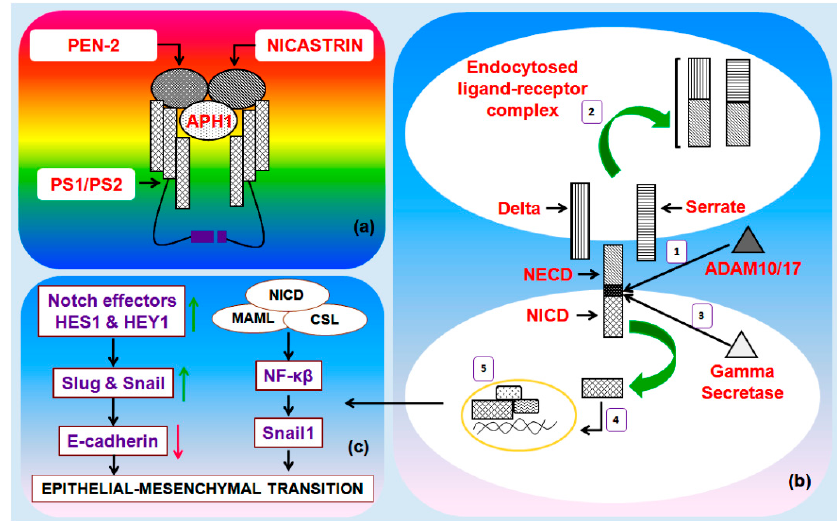
Figure 2. (a)The gamma secretase ( γ -secretase) complex: It is comprised of presenilin enhancer (PEN-2), anterior pharynx-defective 1 (APH1) and nicastrin. Presenilins (PS1/PS2) are the catalytic